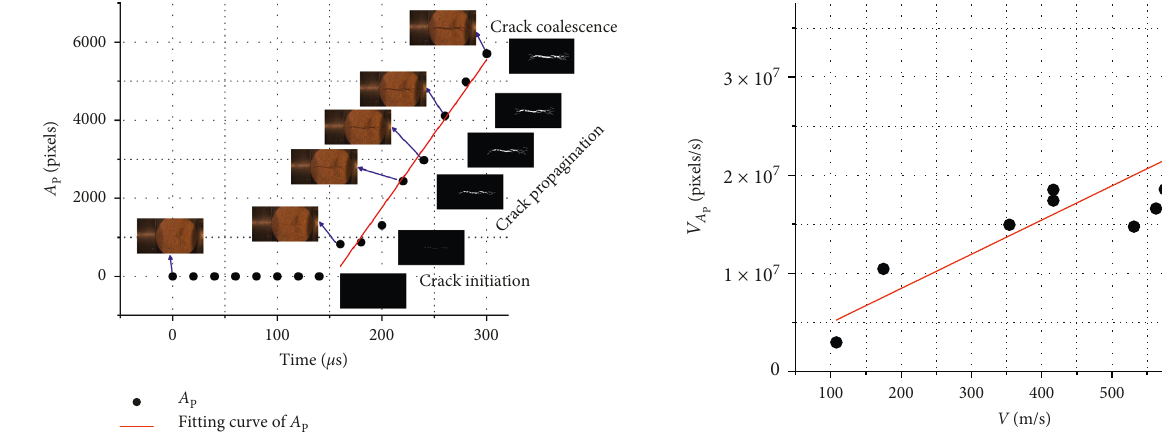
A P of rock specimens